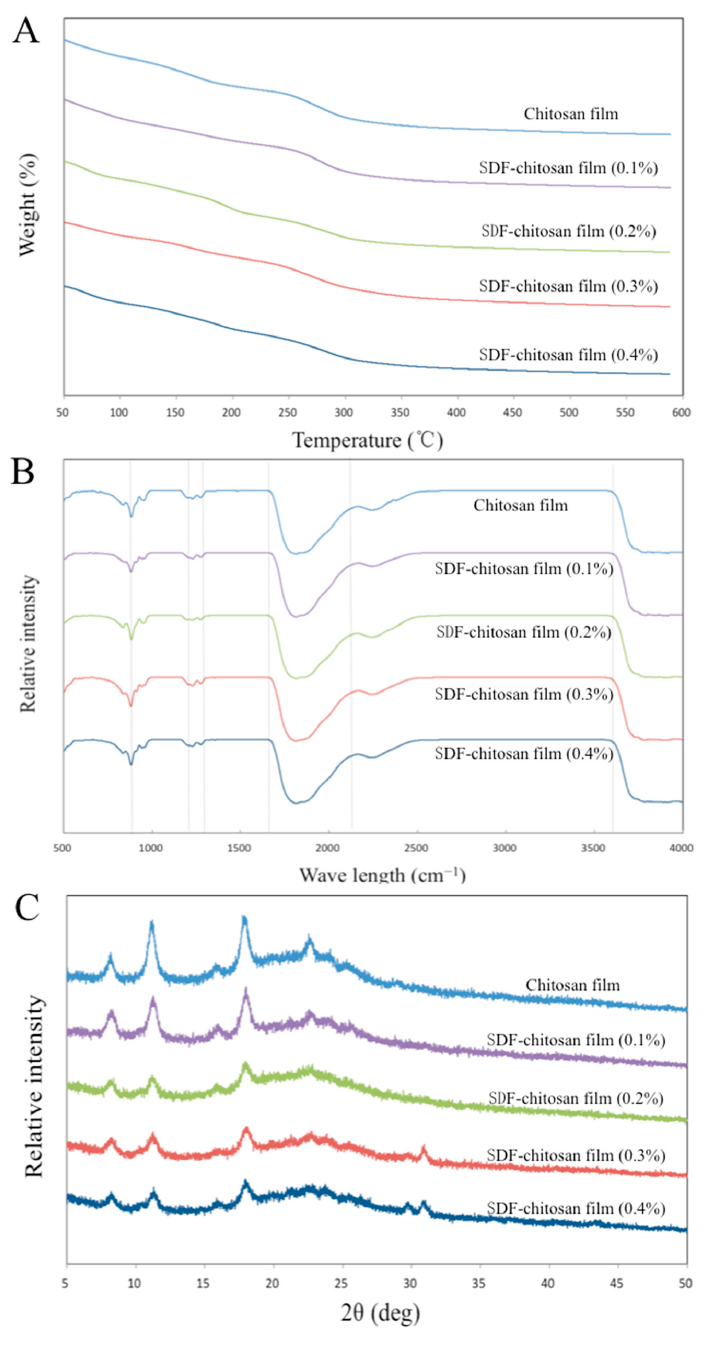
Figure 4. TGA analysis ( A ), FT-IR spectra ( B ), and XRD patterns ( C ) of